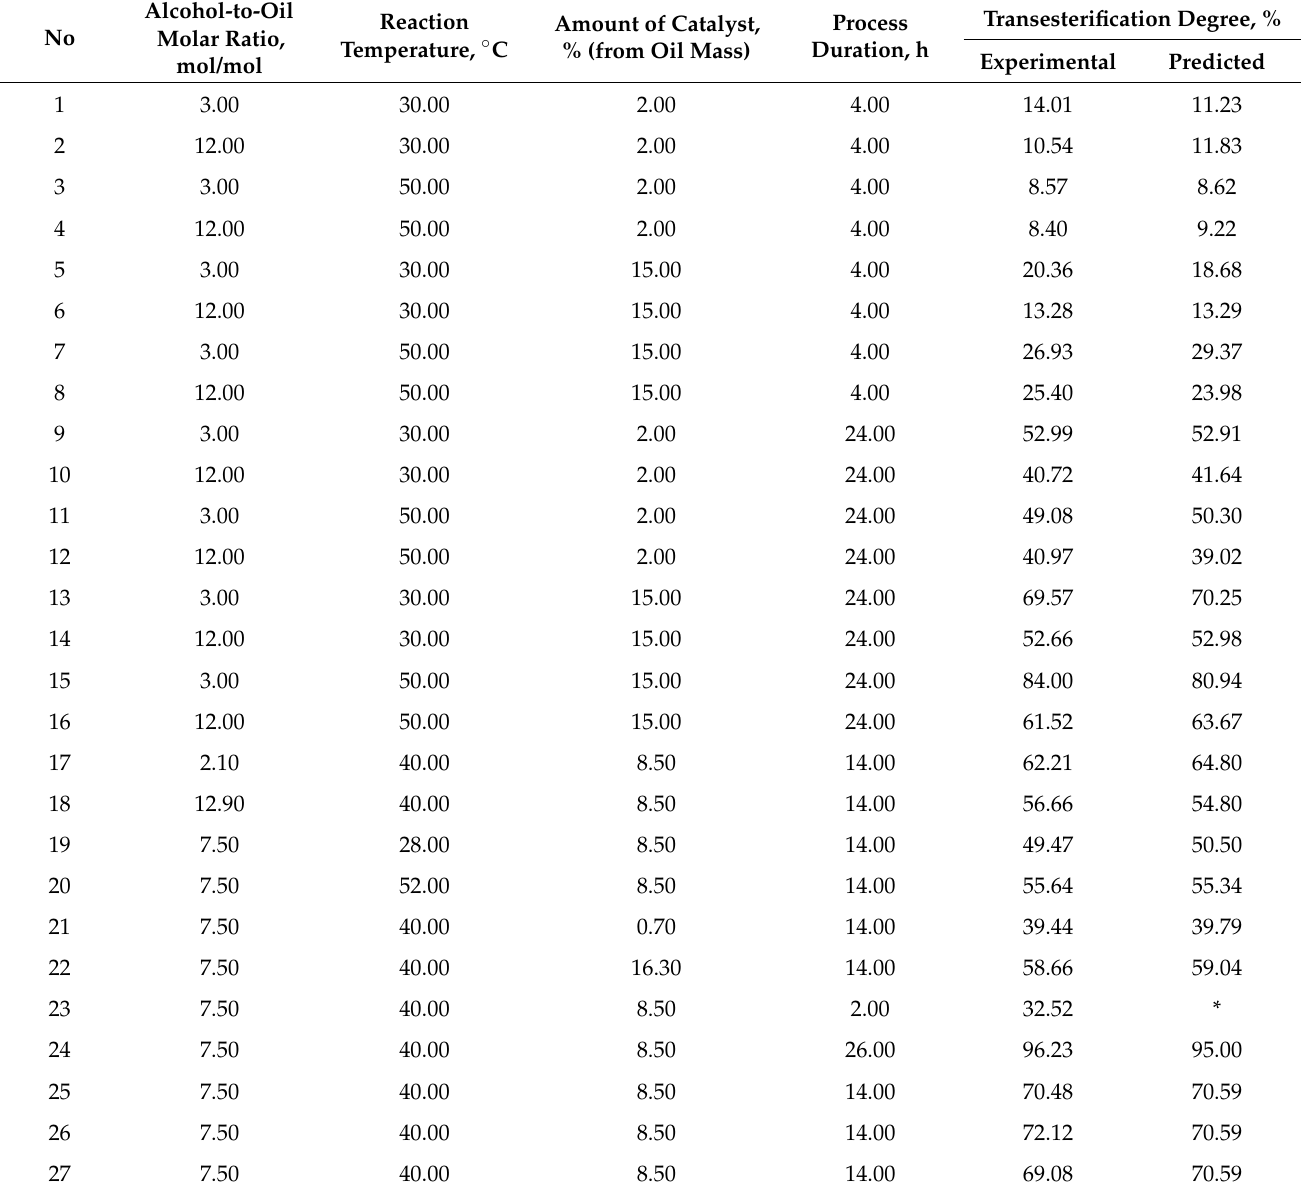
Table 2. Central composite design matrix and observed and modelled